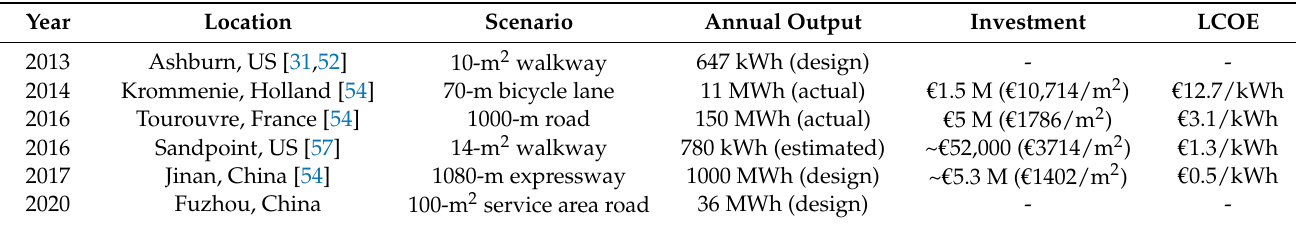
Table 2. Existing applications of solar